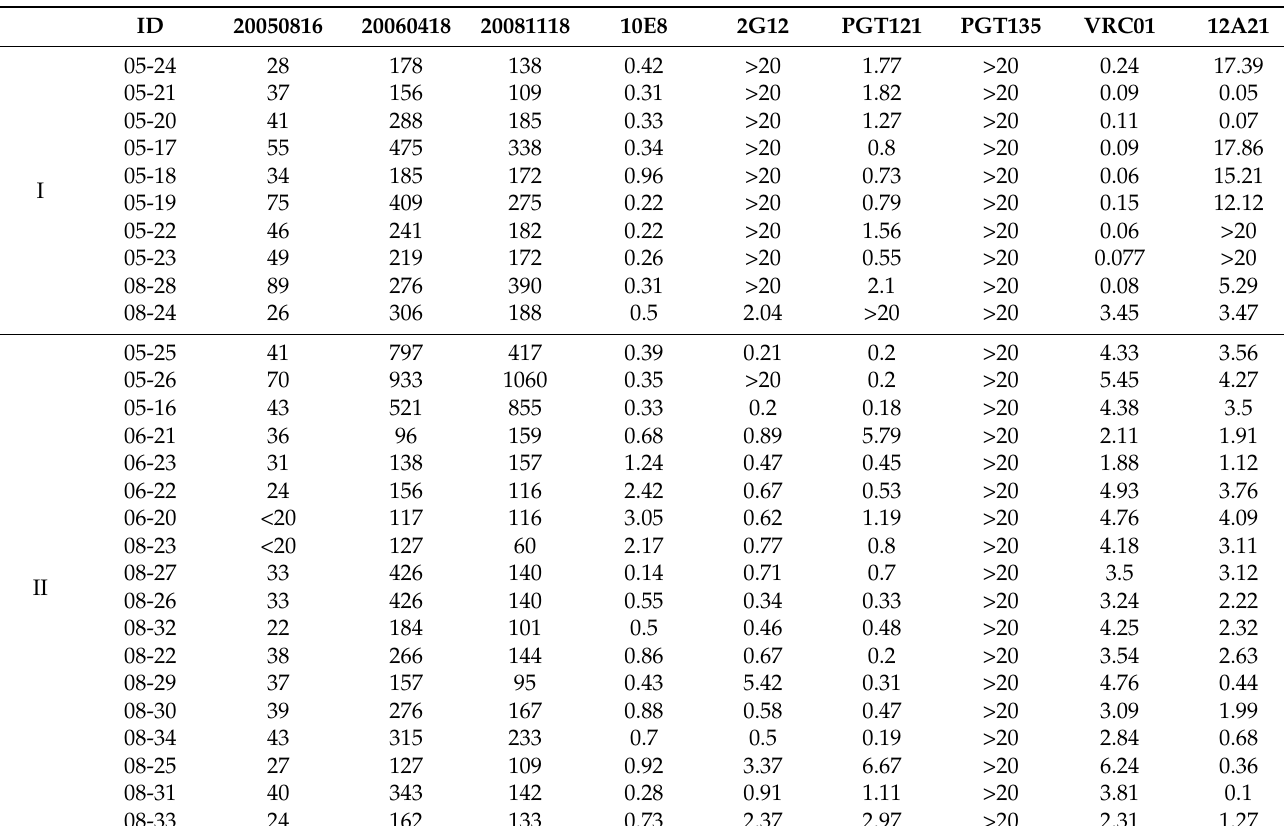
Table 3. Neutralization sensitivity of Cluster I and Cluster II viruses to autologous plasma/broadly neutralizing antibod- ies (bNAbs) #